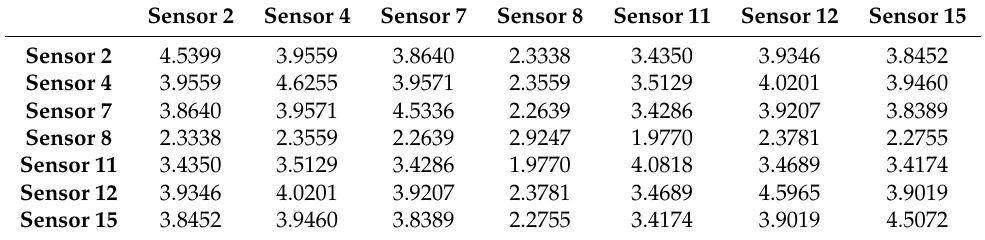
Table 9. Mutual information values among sensors selected by observing strategy for data set